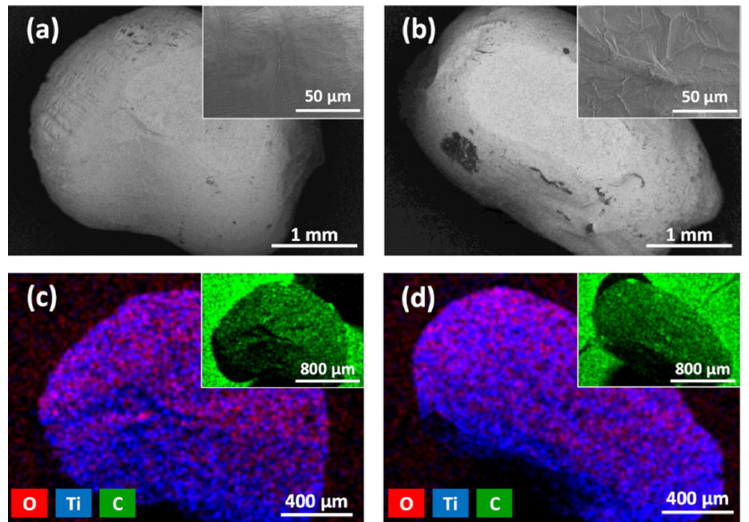
Figure 3. SEM surface images and EDS elemental mapping views of ( a , c ) carbon-doped amorphous TiO 2 and ( b , d ) carbon-doped anatase TiO 2 films deposited on HDPE beads.